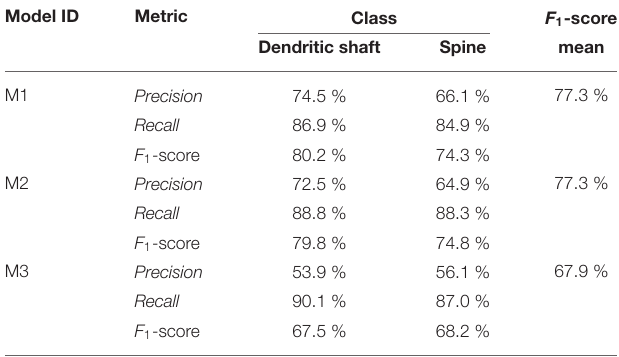
TABLE 1 | Test results of the selected